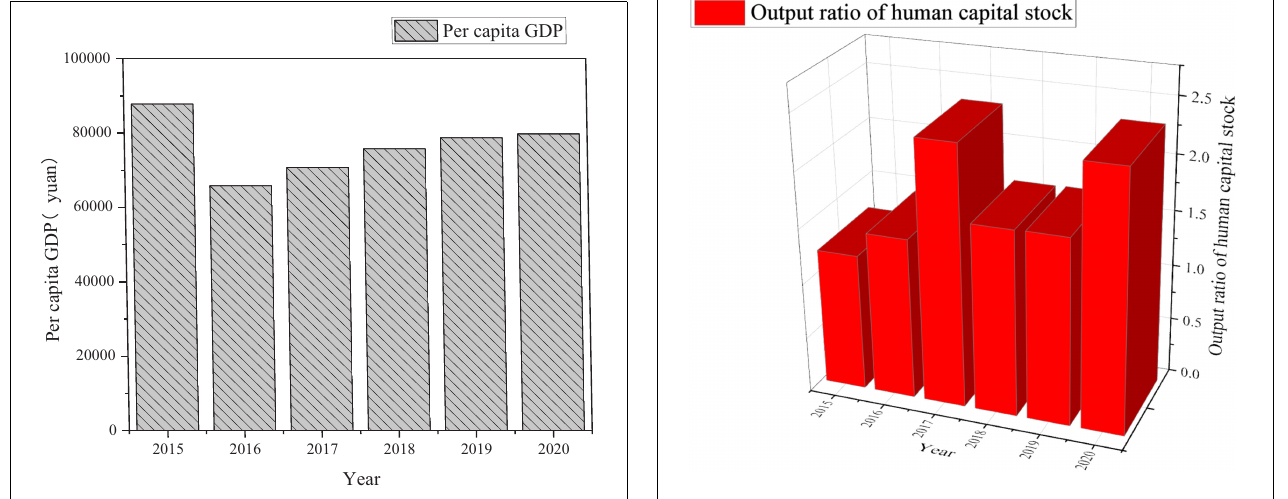
FIGURE 6 | Statistics of per capita GDP in Shenyang from 2015 to 2020.